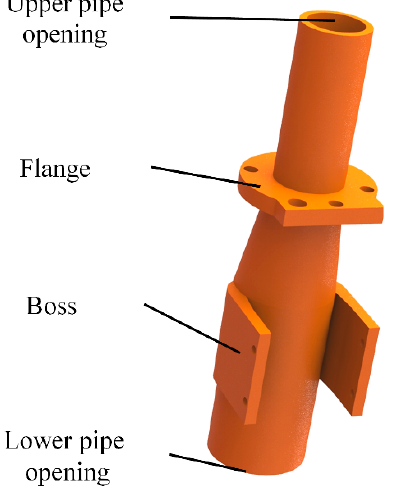
Figure 7. Picking Figure 7. Picking pipe. Figure 7. Picking pipe.